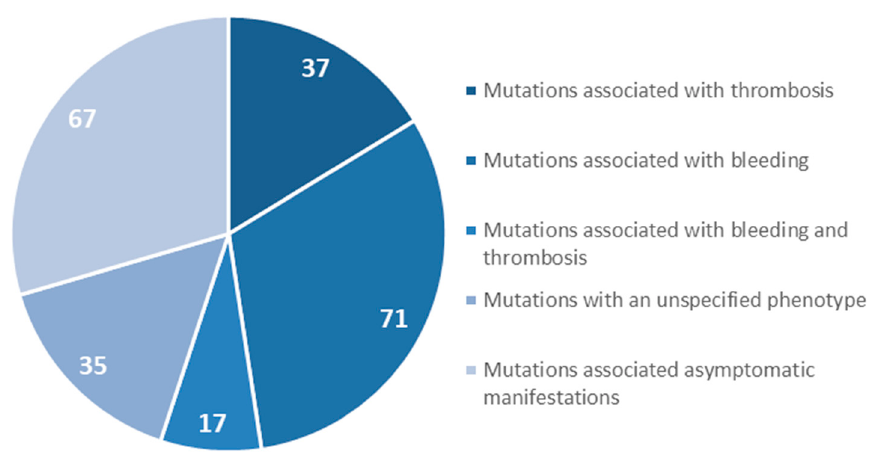
Figure 4. Mutations in exons 5–9 of the FGG gene encoded the fibrinogen γ chain.